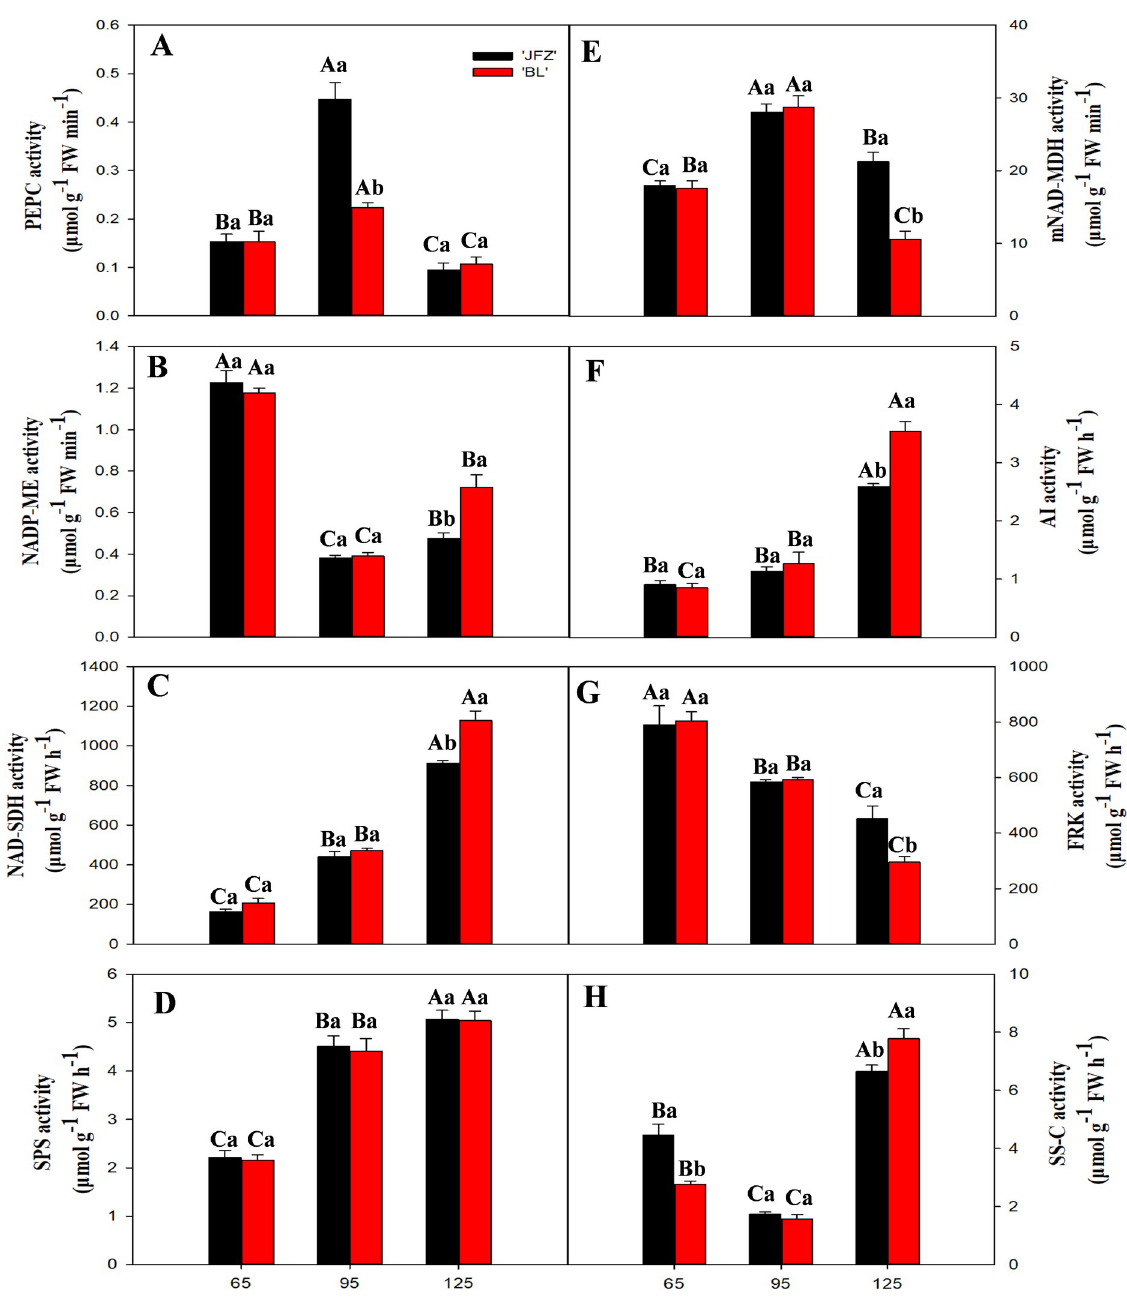
Fig 7. Changes in activities of PEPC, NAD-MDH, NADP-ME, vAI, NAD-SDH, FRK, SPS, and SS-C during fruit of development and ripening. The samples were analyzed for inter-cultivar differences and differences in the sampling dates for the two cutivars. Differences among the samples were analyzed by two (cultivars) × three (sampling dates) ANOVA. The different lowercase letters indicate significant differences between the two cultivars at the same time point at p < 0.05. The different capital letters indicate significant differences among different time points for the same cultivar at p < 0.05. Each point represents the mean ± SD (n = 3). [42]. We observed that ALMT9 in two cultivars was upregulated during fruit development, and its expression in JFZ was higher than in BL at 125 DAF. Therefore, ALMT9 may partici- pate in the control of malic acid accumulation in the vacuole during fruit development. Similar